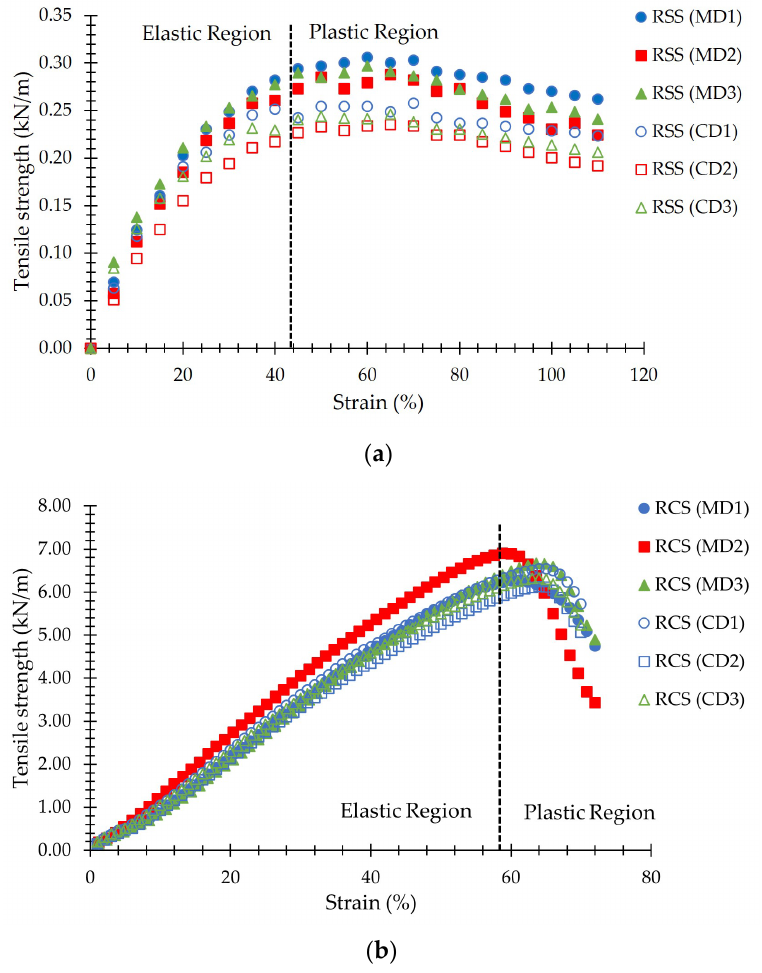
Figure 3. Tensile strength ( a ) RSS geogrid ( b ) RCS geogrid.